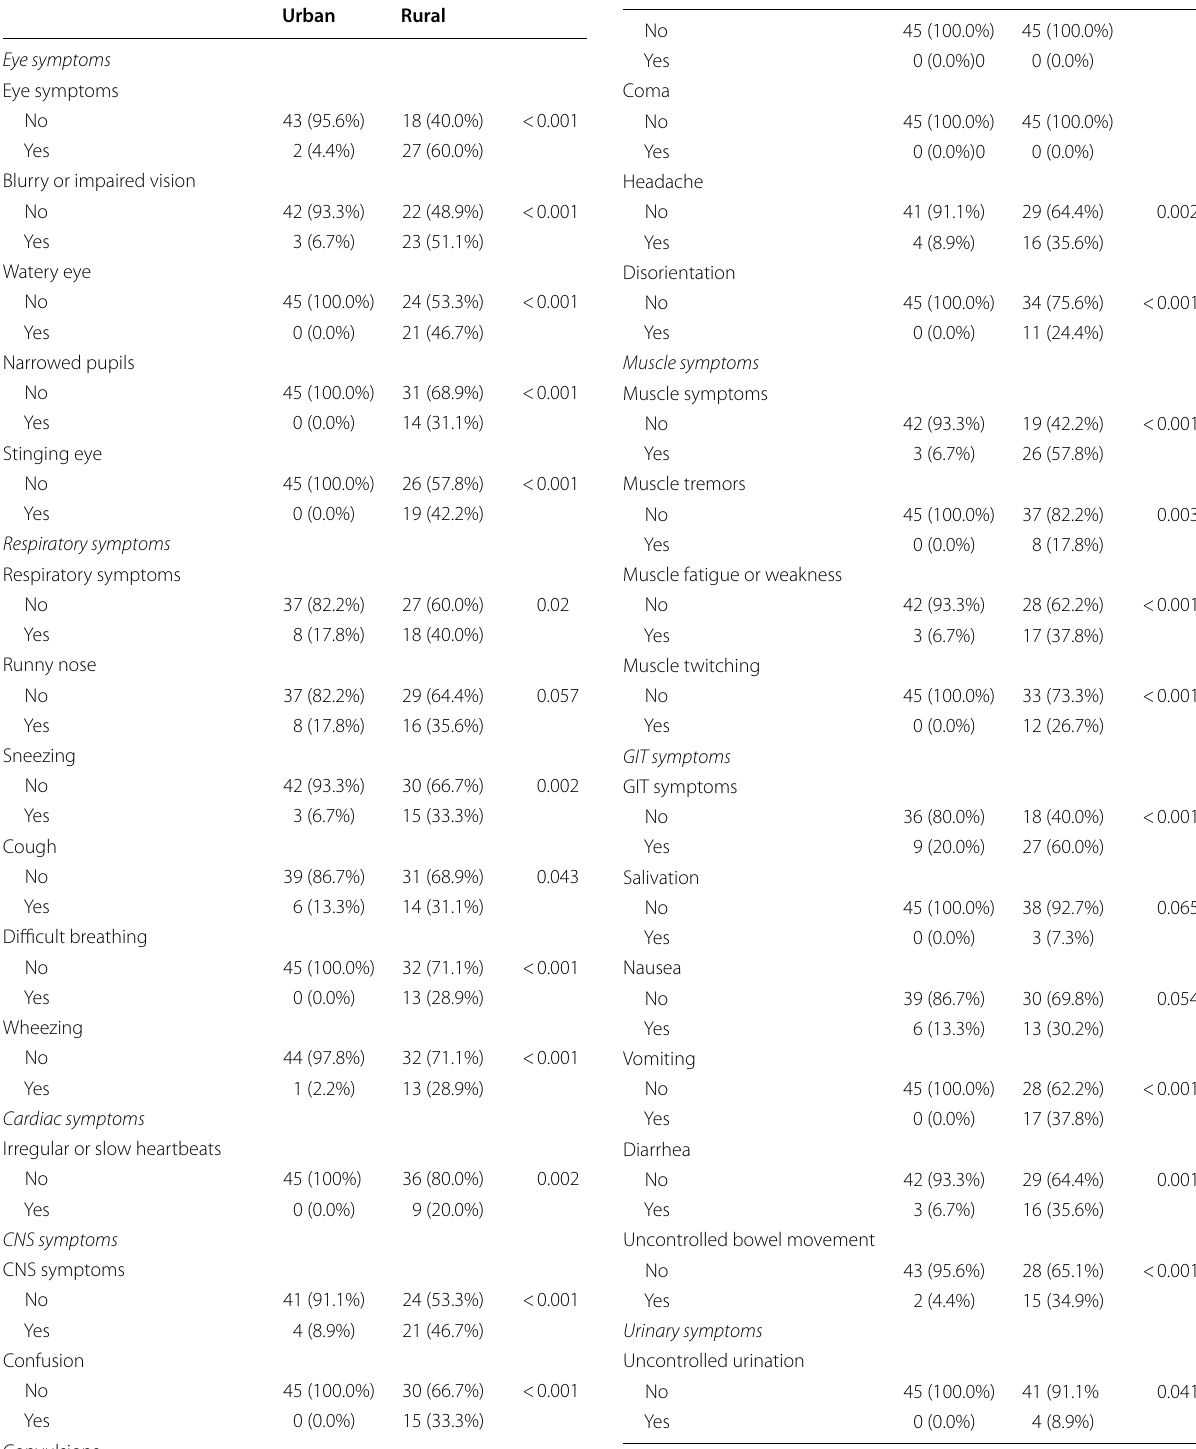
Table 3 Comparison between the study groups as regard frequency of clinical